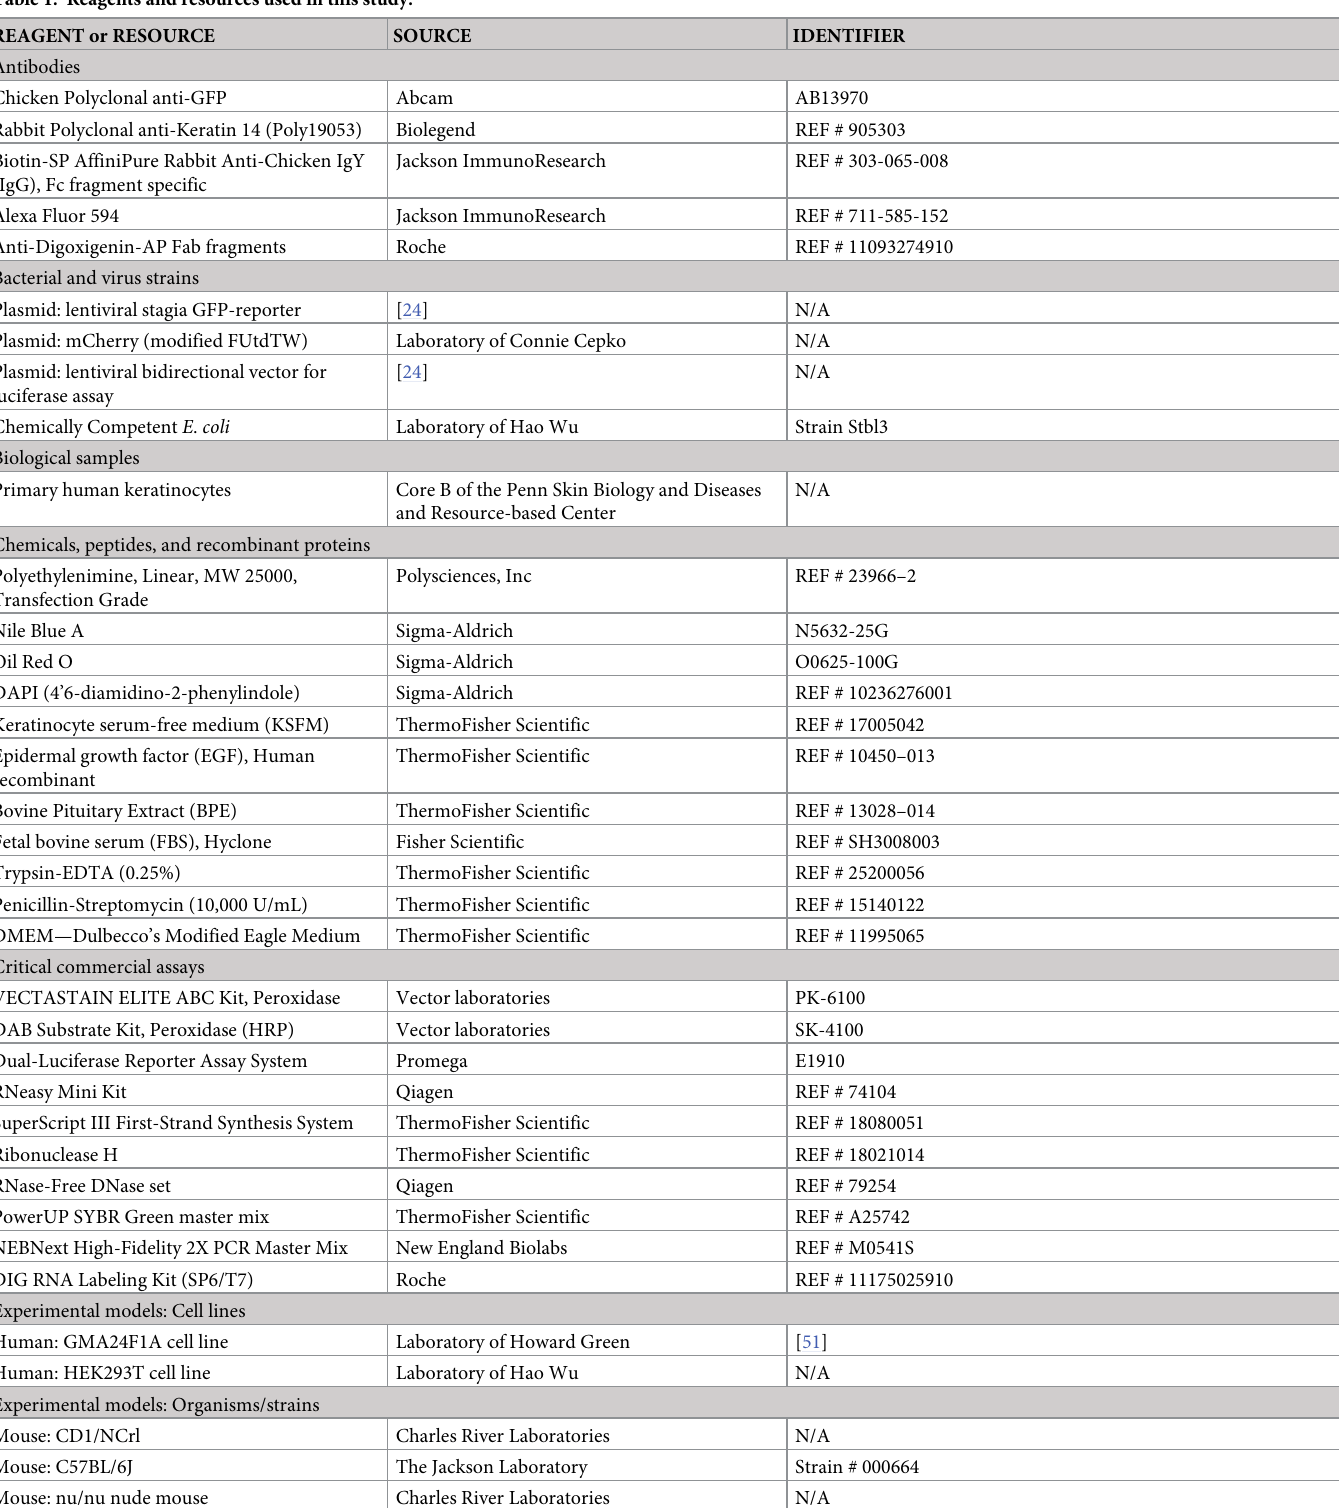
Table 1. Reagents and resources used in this